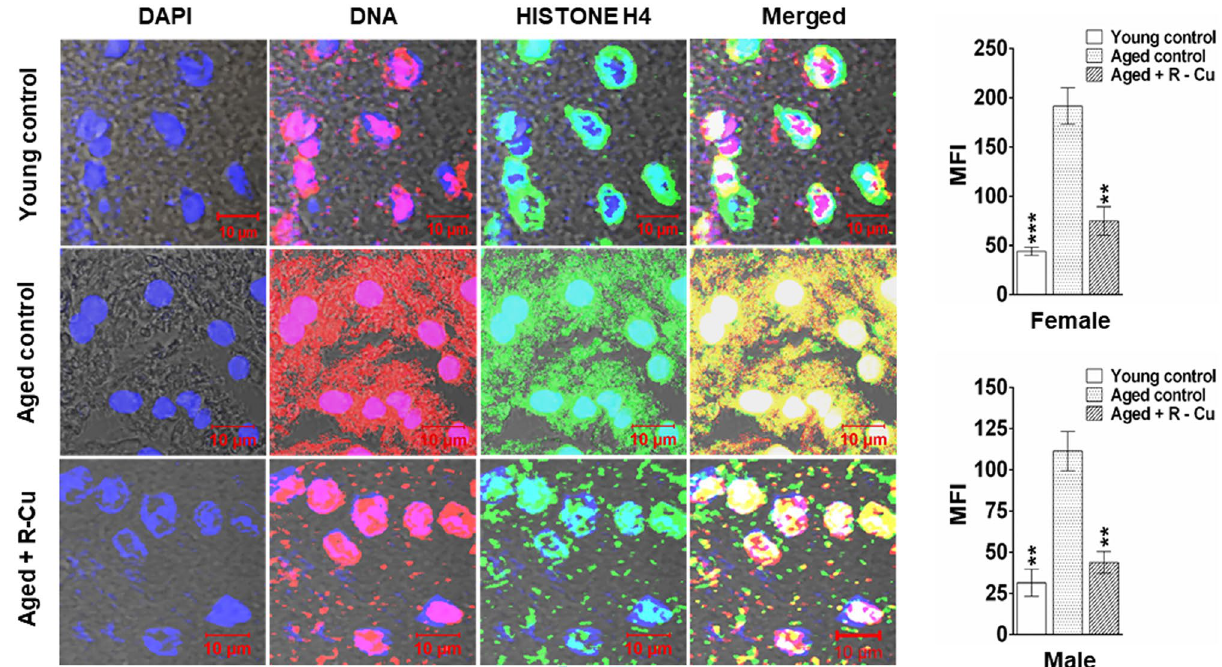
Figure 2. Copious presence of cfChPs in extra- cellular spaces of ageing brain and their deactivation/ eradication by R–Cu treatment. Representative confocal images of FFPE sections following fluorescent immuno- staining with anti-DNA (Red) and anti-histone antibodies, showing co-localization of red and green signals to generate yellow/white coloured particles which represent cfChPs (left hand panel). Quantification of yellow IF signals expressed as histograms (right hand panel). Fluorescence intensity of five randomly chosen confocal fields (~ 50 cells in each field) from each section was recorded. Bars represent mean ± SEM values. N = 4 animals in each group of both sexes. Values of young control mice and R–Cu treated ageing mice were compared with those of ageing control mice, and statistical analysis was performed by two-tailed Student’s t test. ** p < 0.01, *** p <